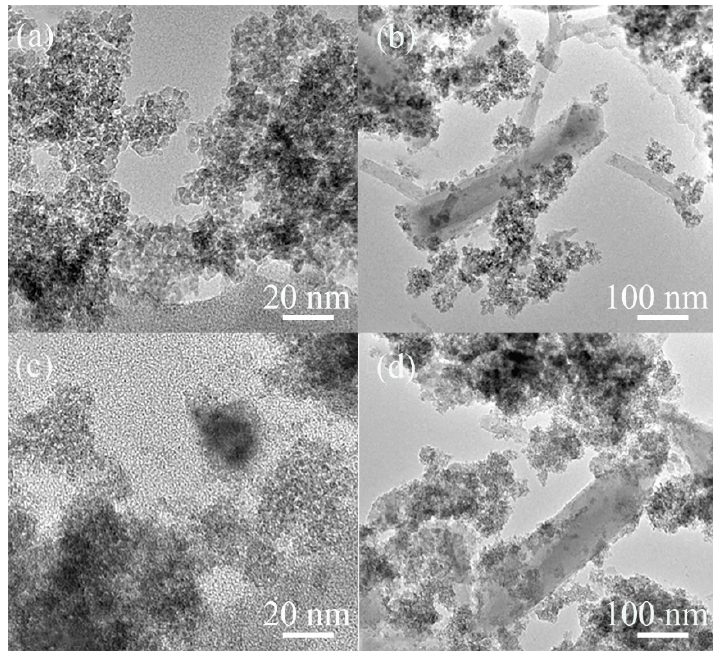
Figure 3. TEM images of ( a , b ) MC and ( c , d ) MCS in different scale plates.